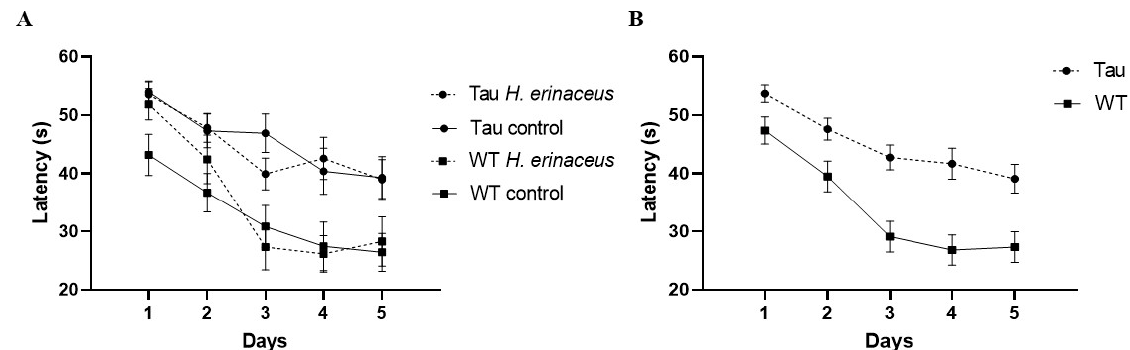
Figure 7. Latency to find the platform in the MWM. ( A ) As the days progressed, mice spent less time finding the platform ( p < 0.001). ( B ) Tau mice had significantly longer latencies to find the platform compared to WT mice ( p < 0.001) Error bars represent mean ± SEM.